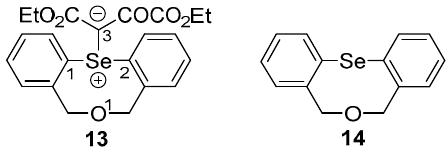
Figure 7. Selenonium ylide 13 and its precursor 14 .